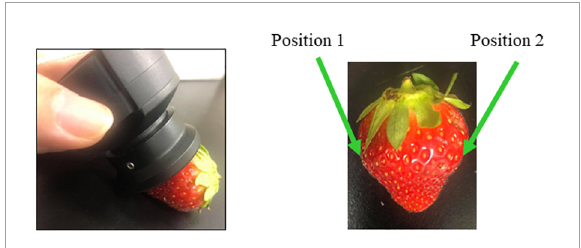
FIGURE1 Acquisition of strawberry spectra using hand-held MicroNIR spectrometer was performed on two measurement